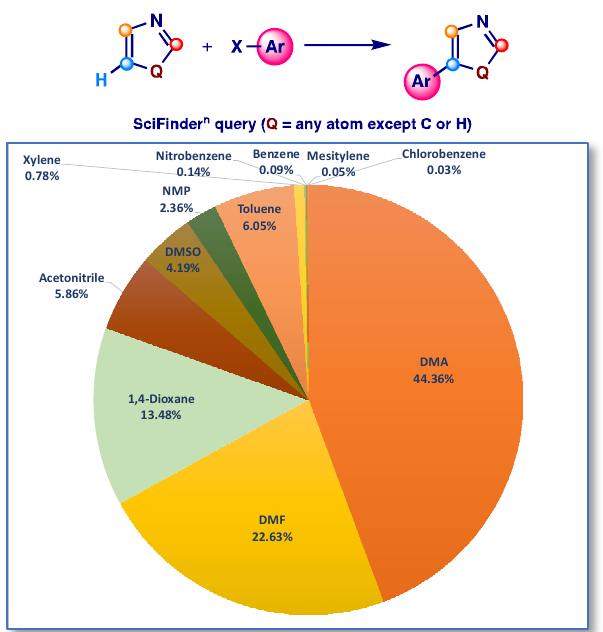
Figure 1. Type of solvents used in Pd-catalyzed direct arylation reactions (from SciFinder n , August 2022).